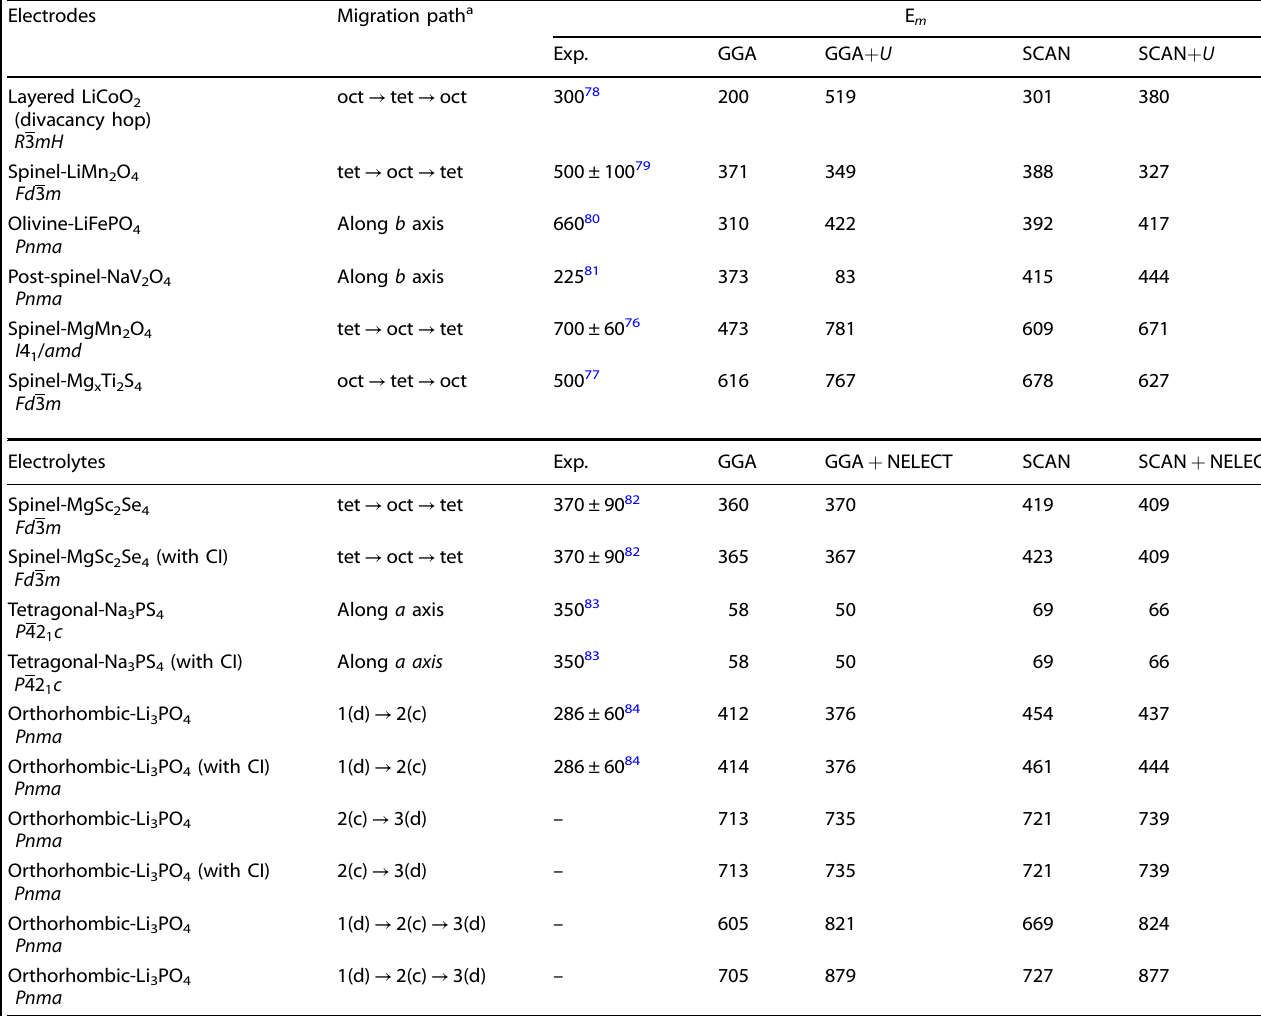
Table 1. Experimental and computed migration barriers E m (in meV) of all materials considered in this work.